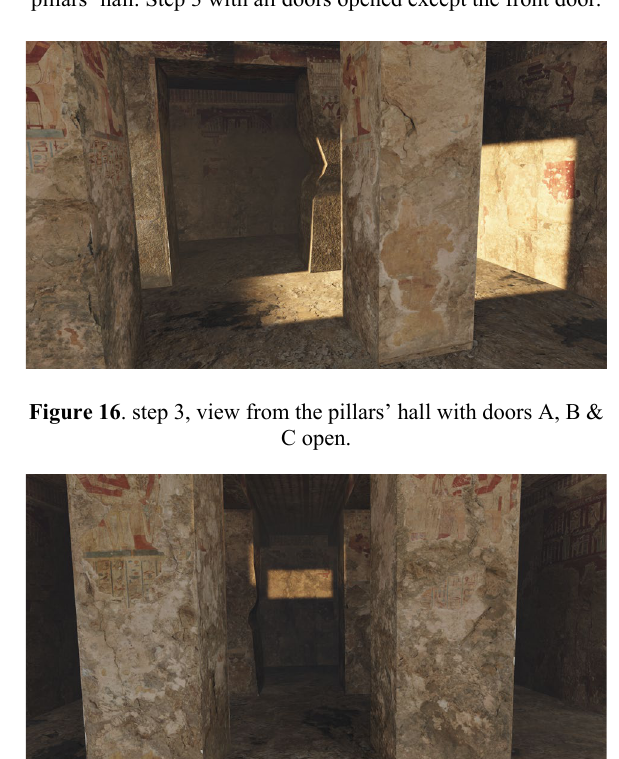
Figure 15 . View from the longitudinal room towards the pillars’ hall. Step 3 with all doors opened except the front door.